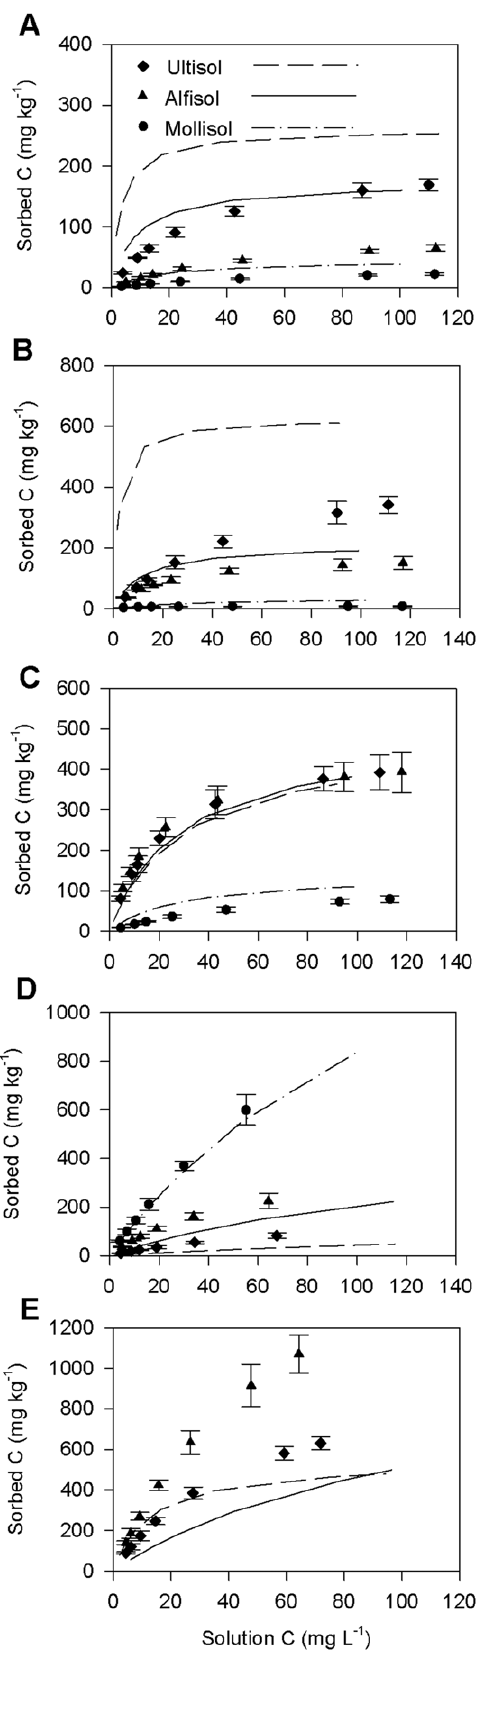
Figure 3. Sorption comparison between sterile and non-sterile Drummer, Jefferson and Malmo soils. (A) D-Glucose, (B) L-Alanine, (C) Salicylic acid, (D) Sinapyl alcohol and (E) Oxalic acid. Symbols correspond to sorption of sterile soils and lines correspond to sorption of non-sterile soils. For (E), data from Drummer soil was not considered because precipitation reaction was predominant than